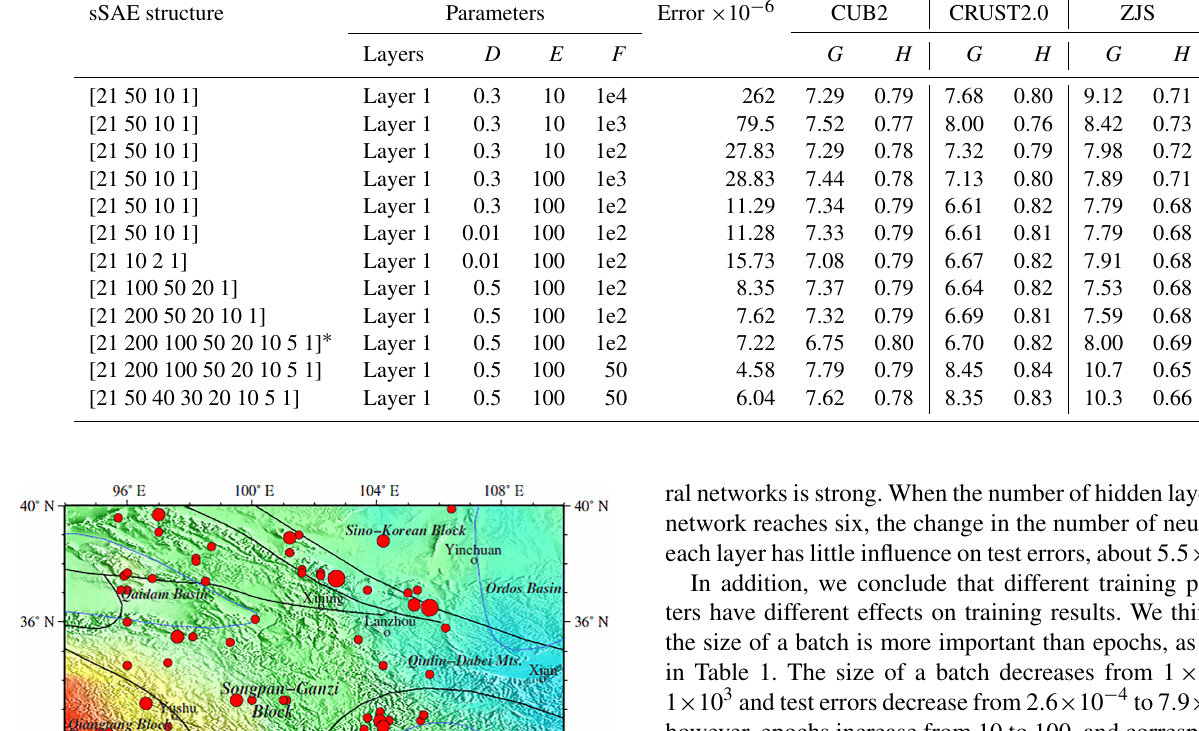
Table 1. Deep learning neural network structures in this article. sSAE structure